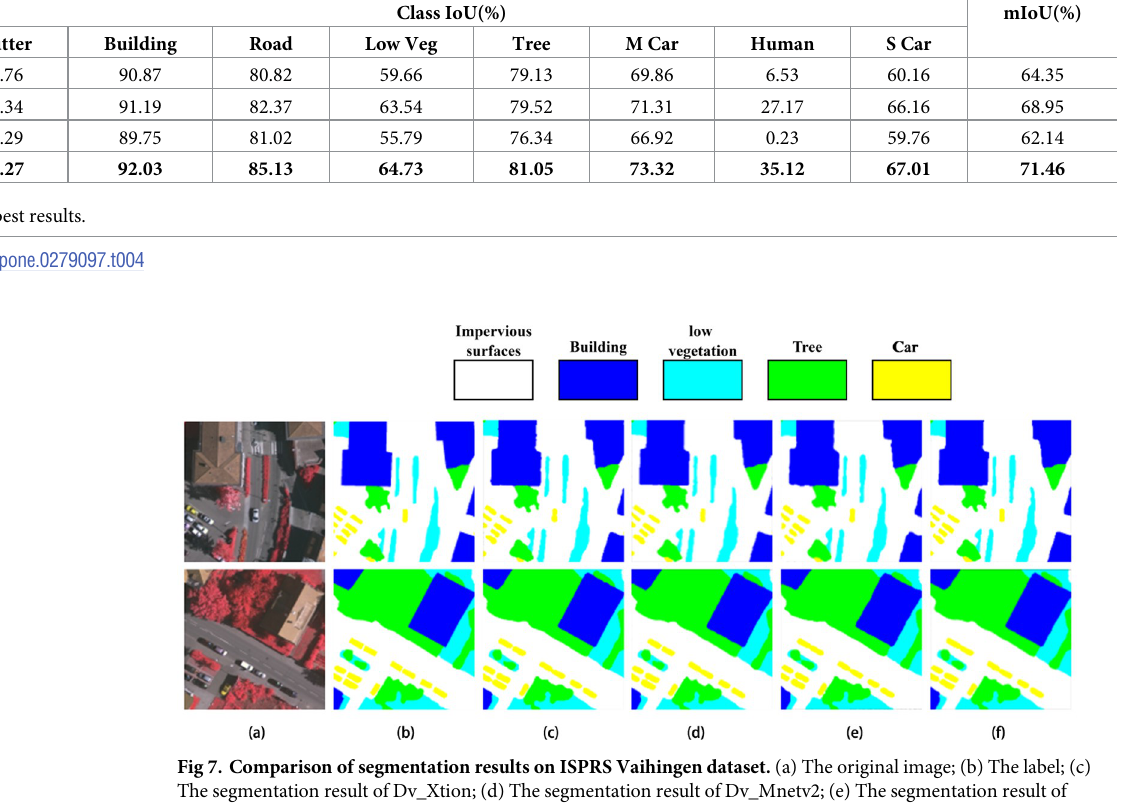
Table 5. Segmentation performance of different models on the ISPRS Vaihingen test set.